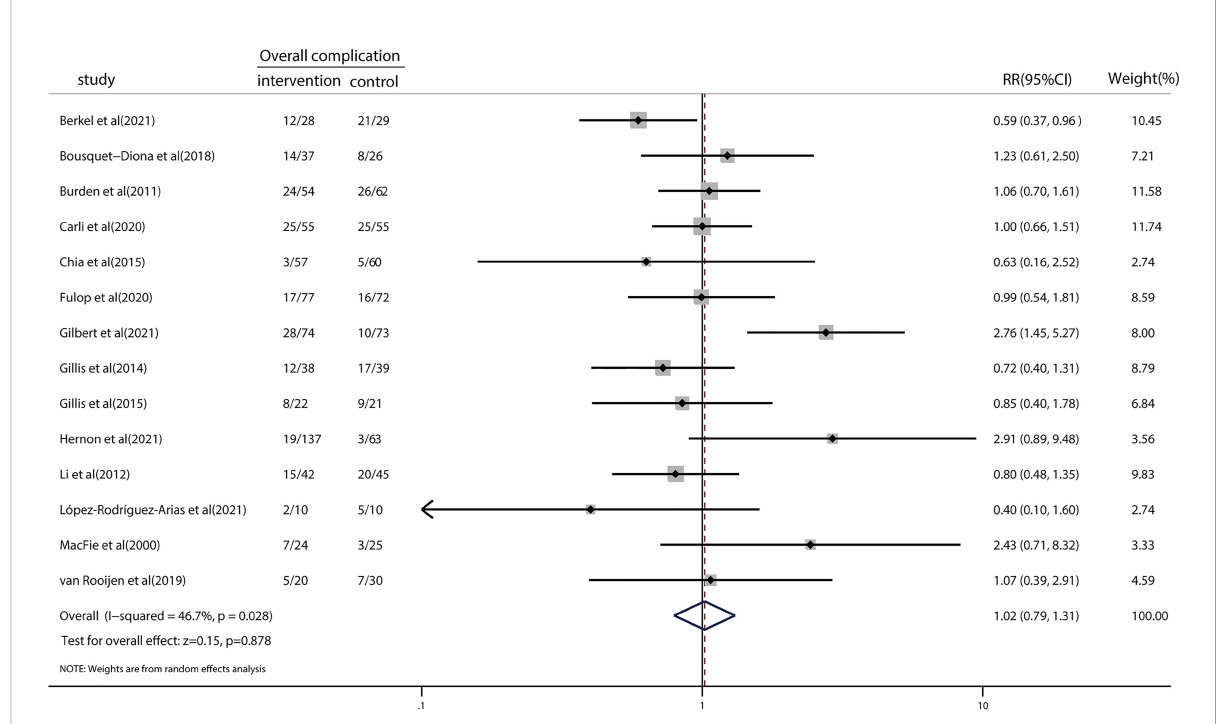
FIGURE 2 Forest plot for overall complications after colorectal surgery with or without preoperative prehabilitation